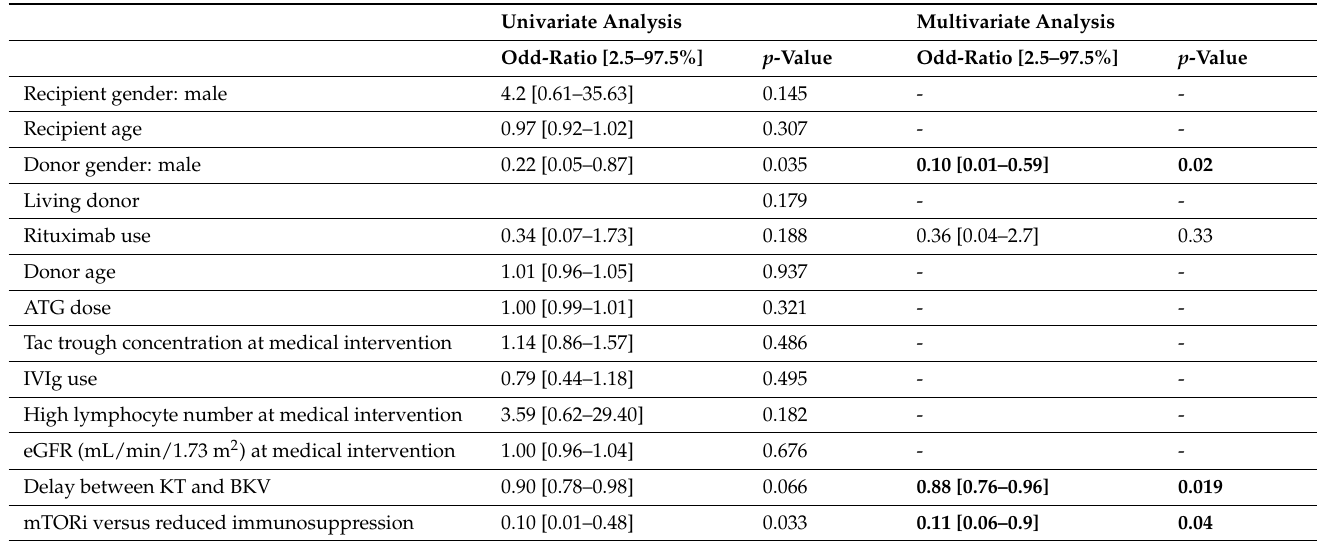
Table 3. Univariate and multivariate analyses of factors associated with BKV DNAemia clearance at 1 year after treatment.